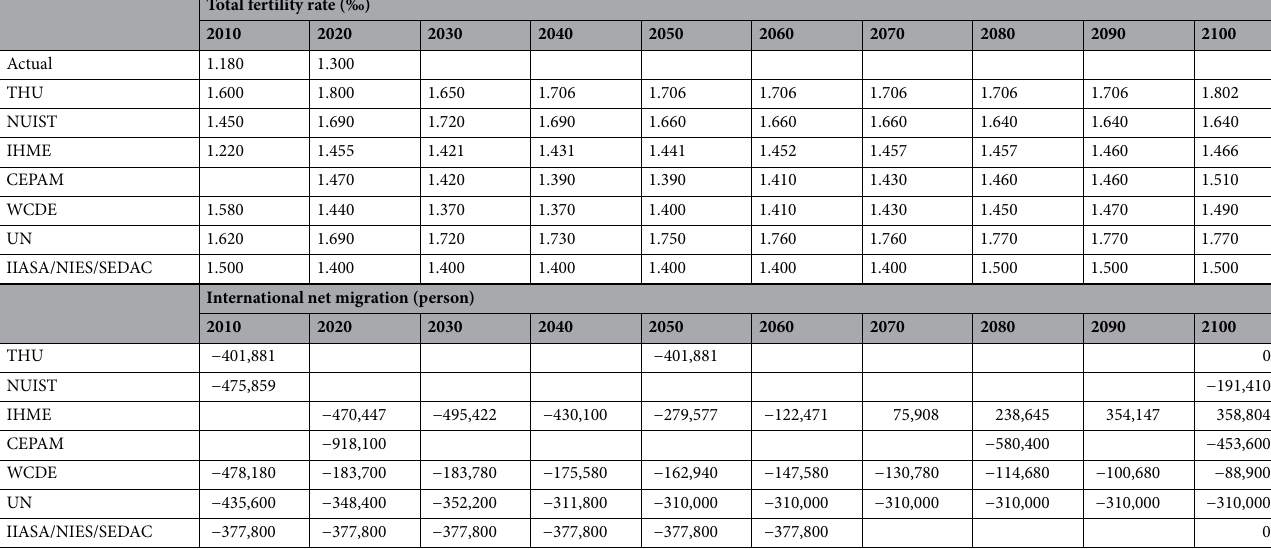
Table 4. The total fertility rate (TFR) and net migration of projection datasets. *The empty table cells mean original researches do not provide these